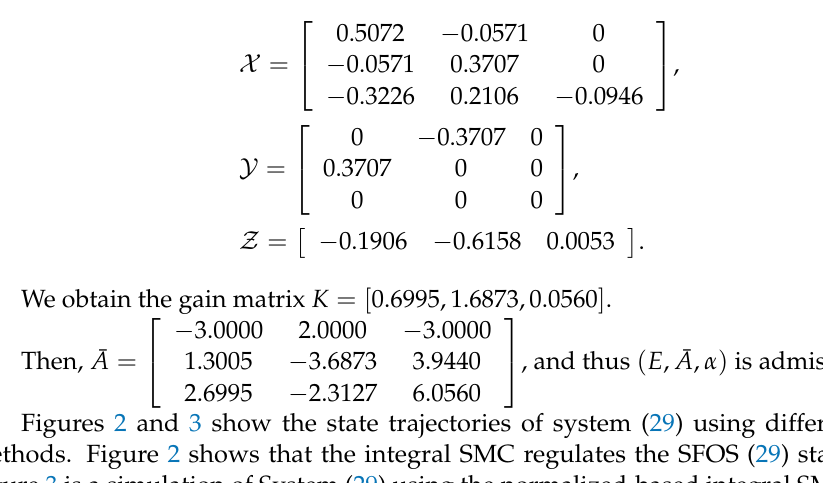
Figure 3 is a simulation of System (29) using the normalized-based integral SMC